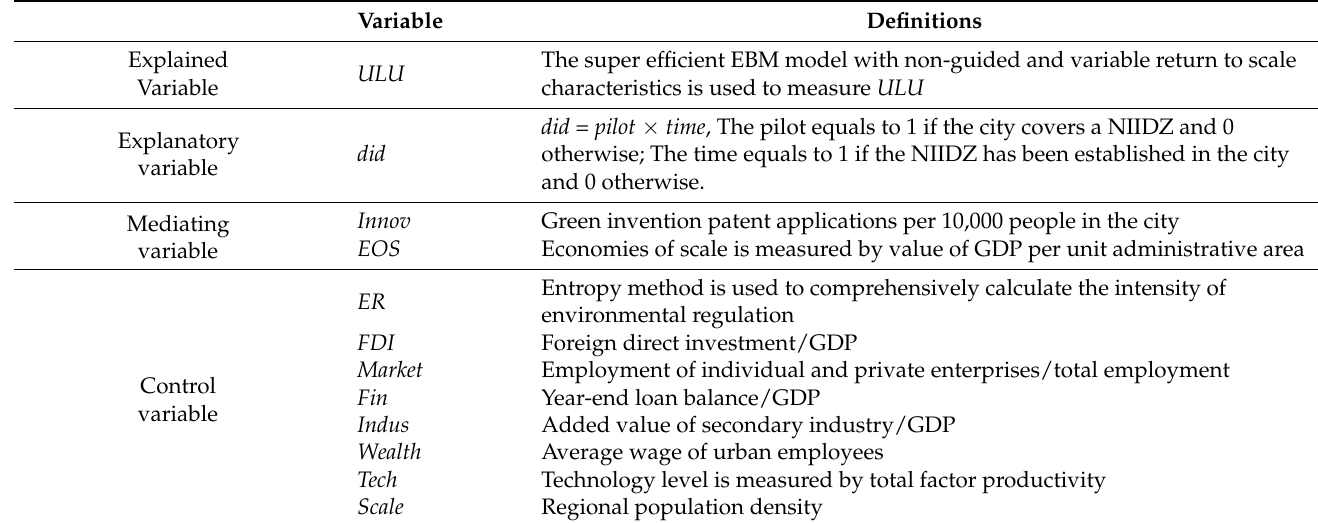
Table 2. Variable definitions.